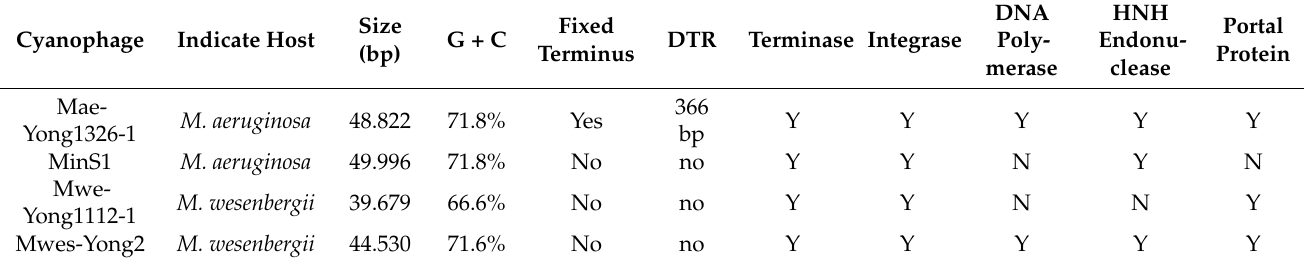
Table 3. Genome-characteristics of Microcystis cyanophages Mae-Yong1326-1, MinS1, Mwe-Yong1112-1, and